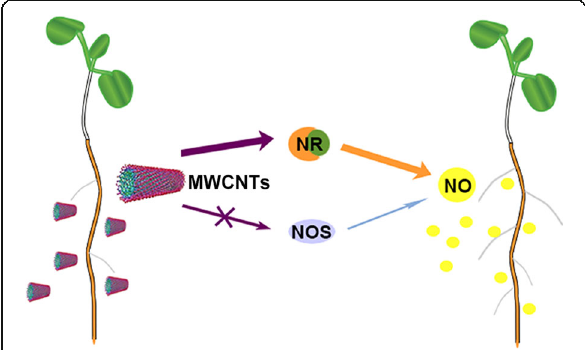
Fig. 8 Schematic representation of the proposed MWCNT-induced tomato lateral root formation mainly via NR-dependent NO production. The role of mammalian NOS-like enzyme was preliminarily ruled